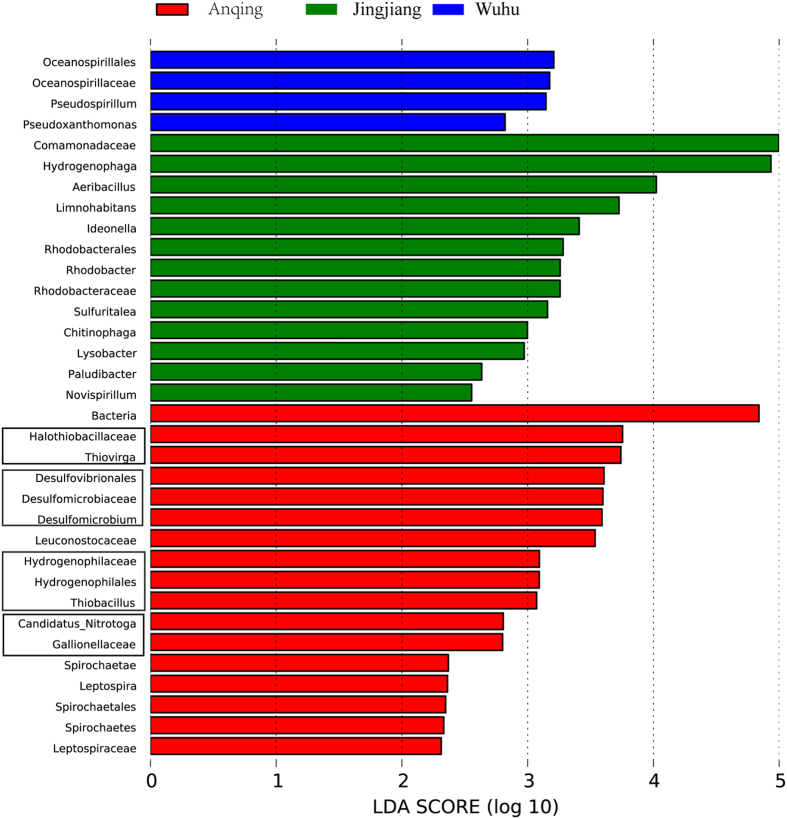
LEfSe identified the most differentially abundant taxa in specific sampling sites.The red, green and blue colors represented bacterial communities of Anqing, Jingjiang and Wuhu respectively. Only taxa meeting an LDA significant threshold >2 were shown in the figure. The taxa in the same rectangles that were related to sulfur and nitrogen recycles were subordinate relationships.